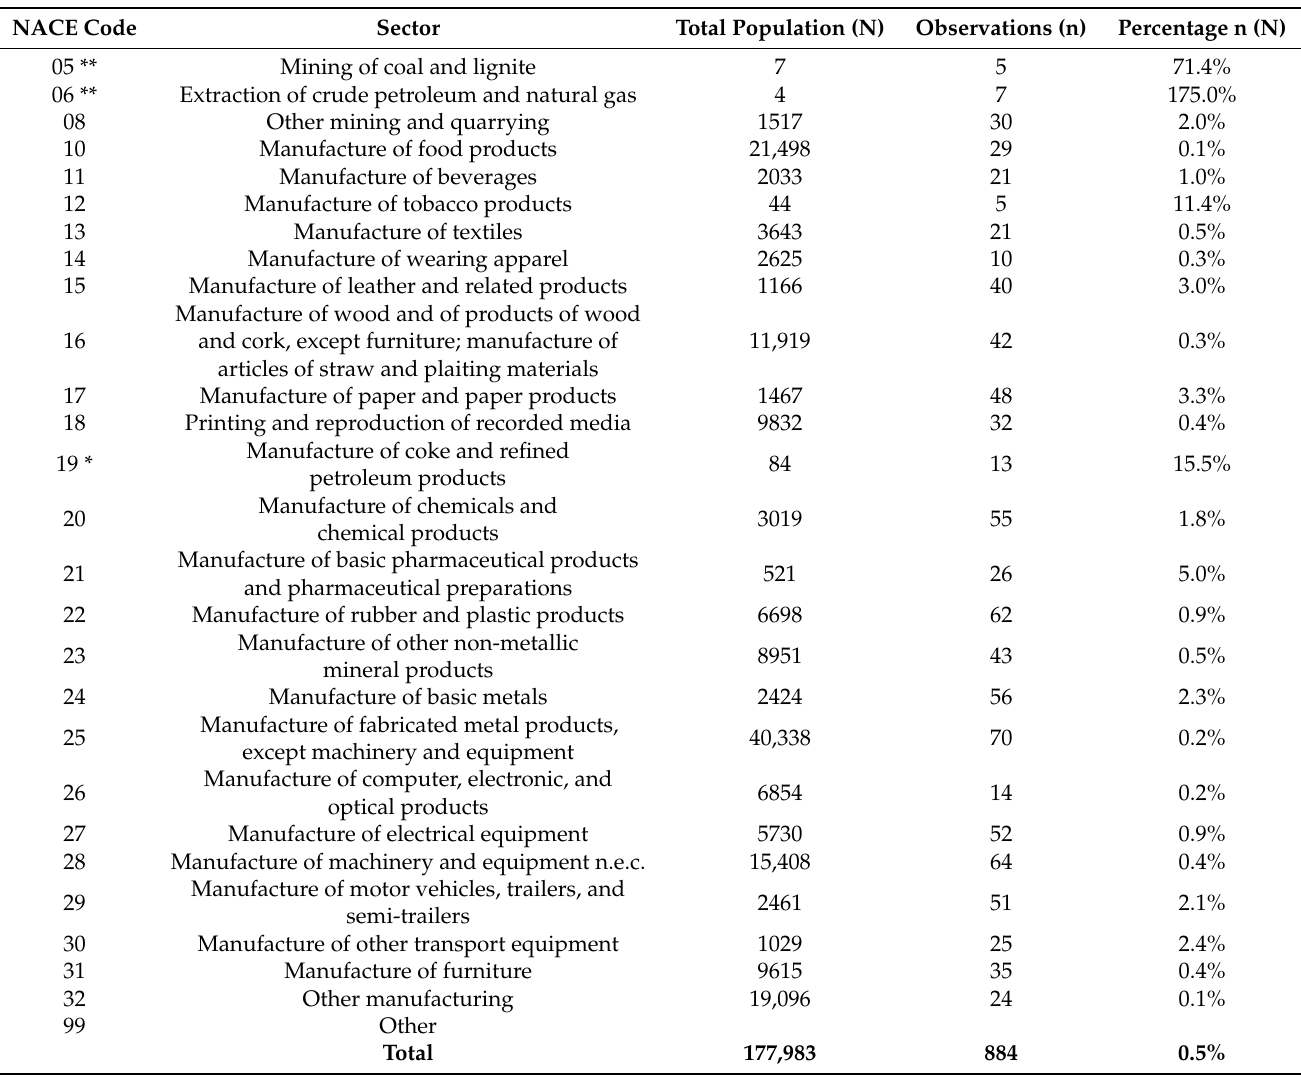
Table 2. Sample composition by sector (n = 884).